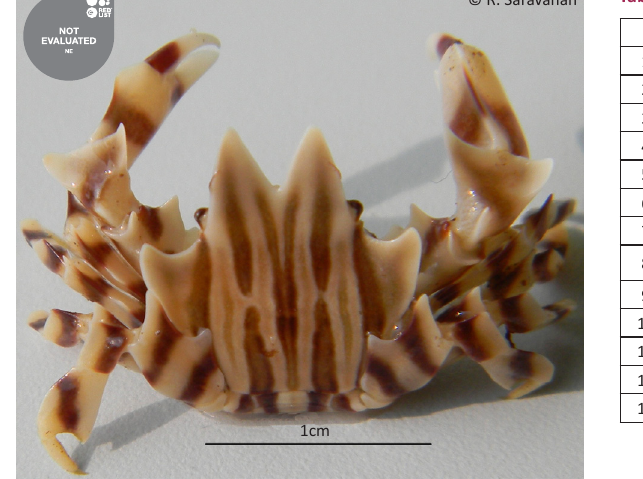
Table 1. The list of host and crab symbiont species (Thiel et al. 2003)